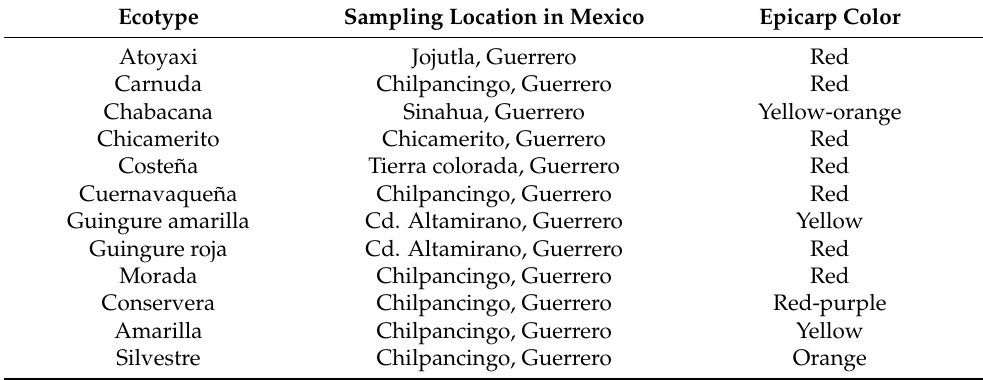
Table 1. Sampling location and epicarp color of the 12 analyzed ecotypes of S. purpurea